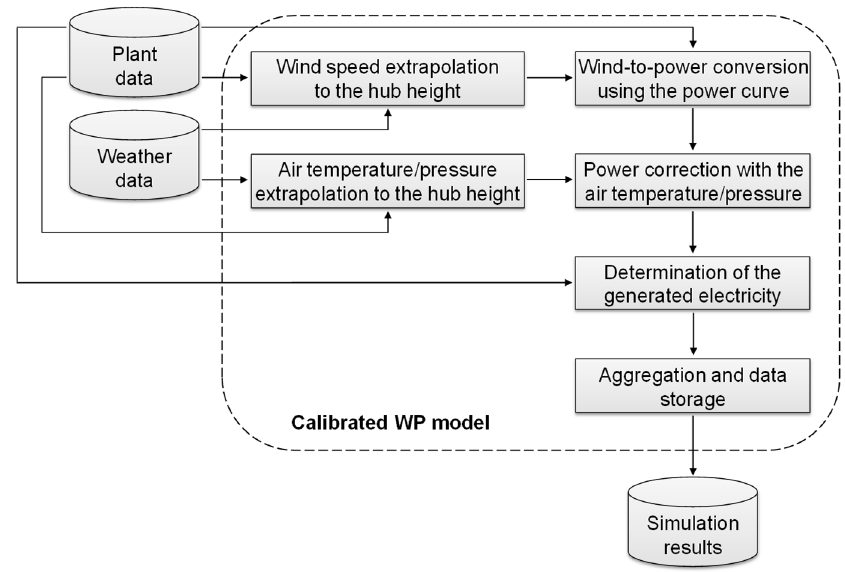
Figure 5. Structure of the WP model shown as a flowchart.